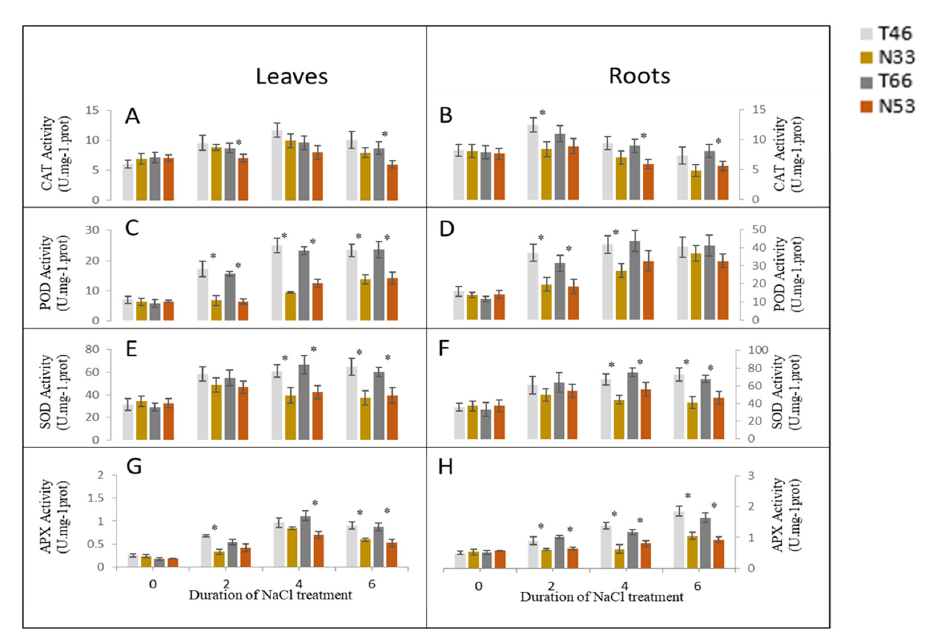
Figure 4. Comparison of , H 2 O 2, MDA and proline contents in leaves ( A , C , E ) and roots ( B , D , F ) of two pairs of NILs at 0, 2, 4, and 6 days after 300 mM NaCl treatment. * indicates significant differences among NILs ( p < 0.05, Student’s t ‐ test).